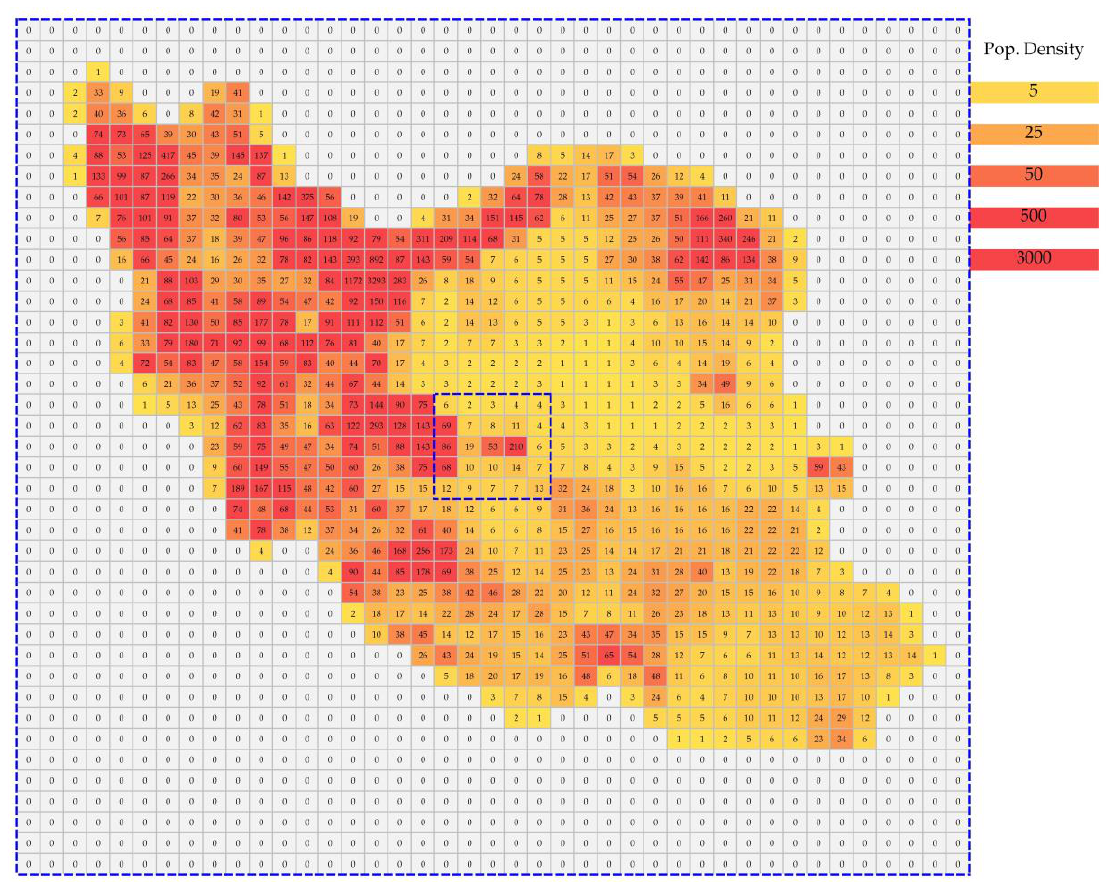
Figure 5. Population density at squares size of 2050 × 2050 and 250 × 250 km around Yazd (#17) power plant.